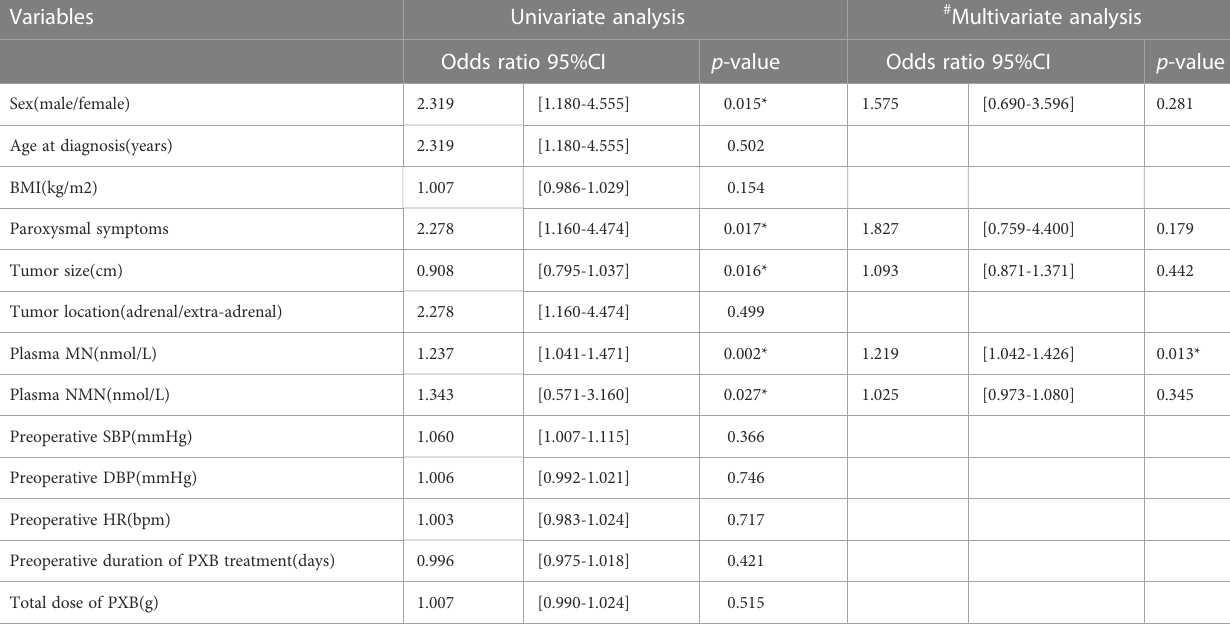
TABLE 7 Predictive factors of perioperative hemodynamics instability for PPGL according to univariate and multivariate analysis.